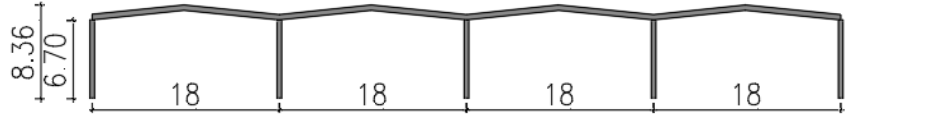
Figure 6. Transverse section.